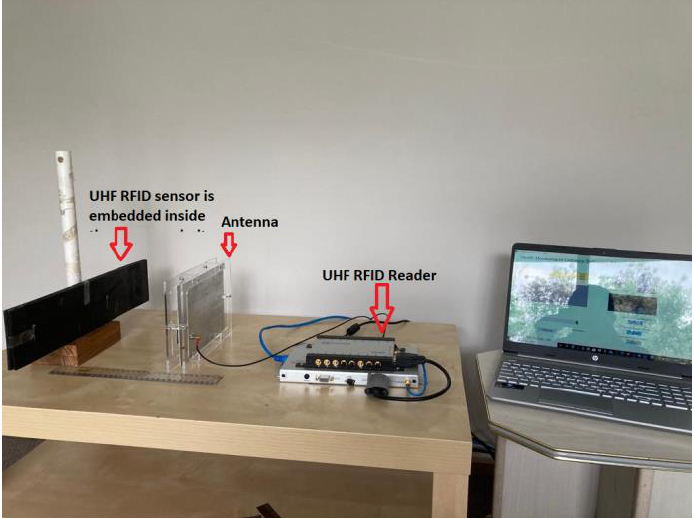
Figure 9. Experimental Setup with fabricated cracked tags.